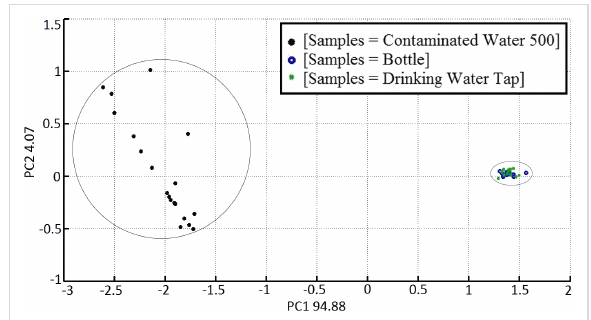
Figure 12: Principal component analysis (PCA) score plot for drinking water (blue and green dots) and a solution with 500 CFU/mL patho- genic microorganisms (black dots).